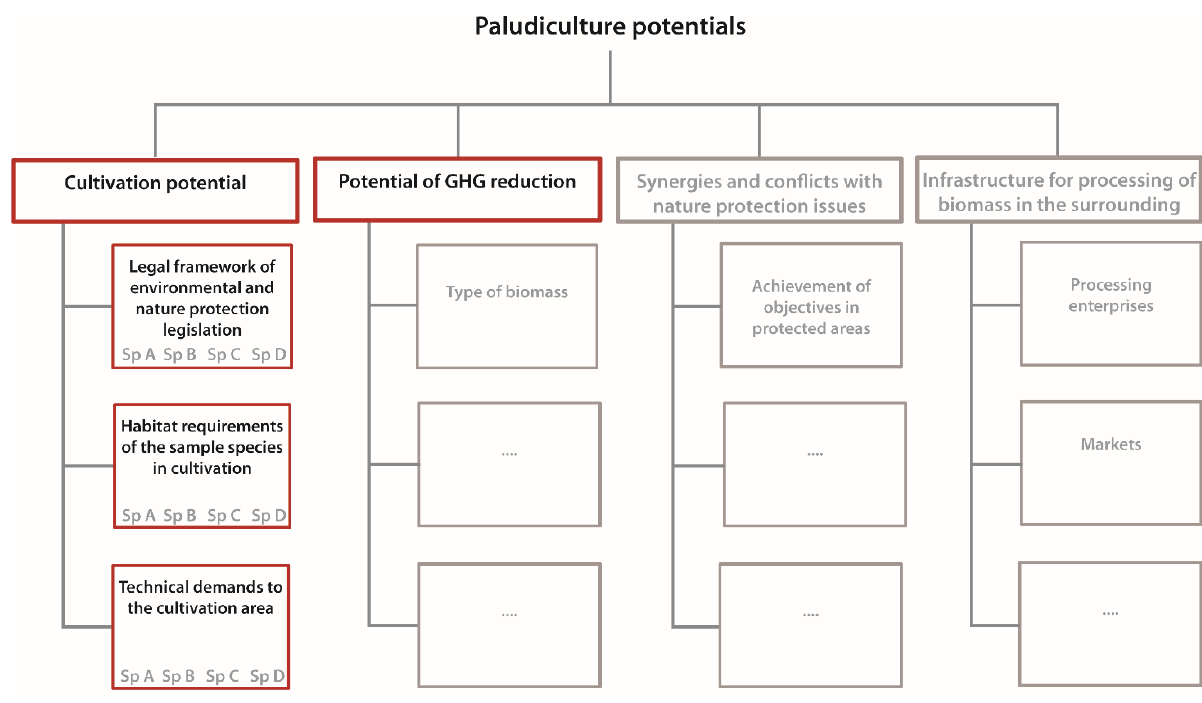
Figure 6: A possible future development of the assessment tool presented here into a modular system. Modifying the structure of the tool in this way has potential to allow the integration of more thematic aspects without impairing its